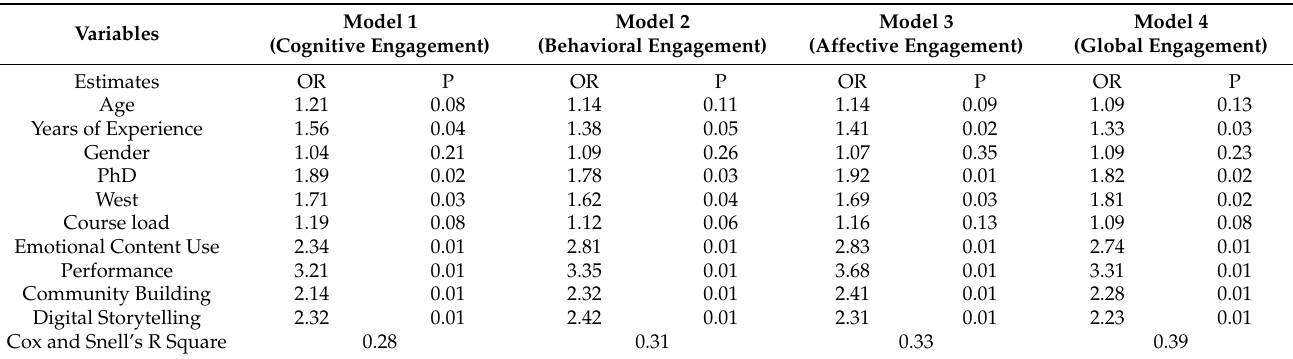
Table 8. Logistic regression results.